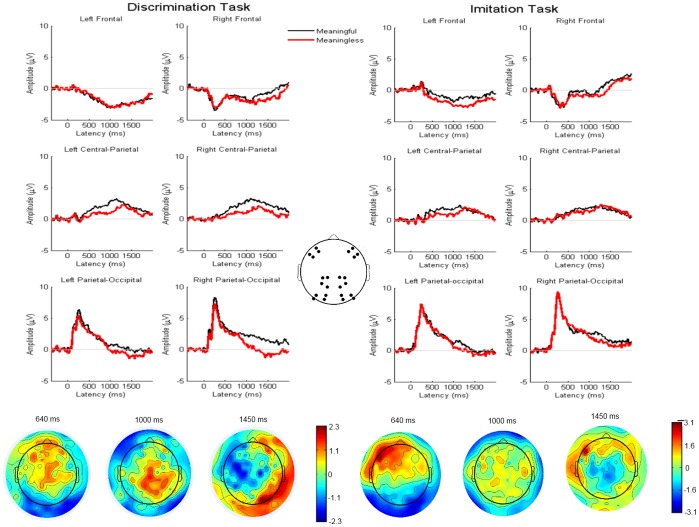
Grand average ERPs and Topographic amplitude difference for meaningful and meaningless actions.Grand average ERPs from imitation task (right panel) and discrimination task (left pannel) for meaningful and meaningless actions, for the frontal, centro-parietal and parietal-occipital ROIs. Central panel: schematic illustration of location of electrodes that each ROI comprises. At the botton: topographic distribution of amplitude difference between meaningful and meaningless conditions including all scalp sites for discrimination (left) and imitation tasks (right), at 640 ms, 1000 ms, and 1450 msec.